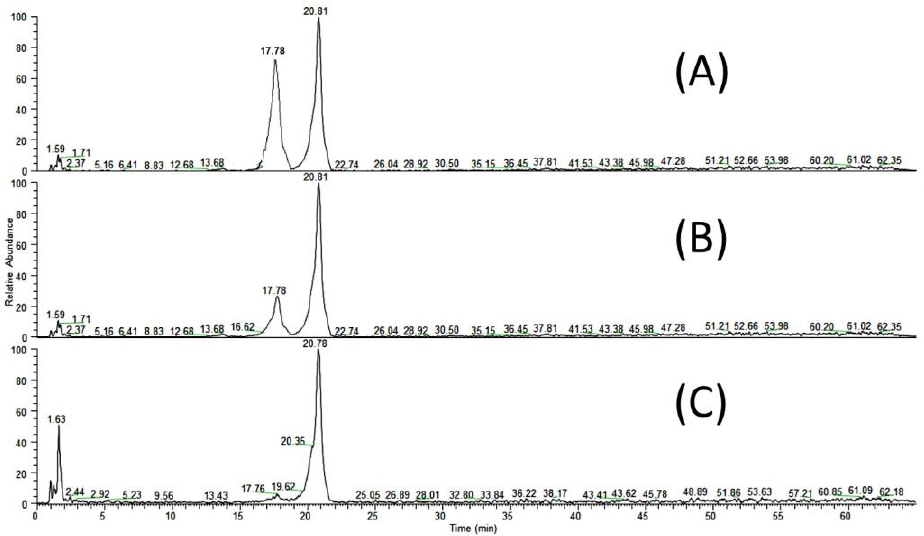
Figure 3. Reconstructed ion chromatograms (RIC) of ions at m/z 441, corresponding to [M + H] + DFP in samples: ( A ) NC white-1 , ( B ) NC yellow , and ( C ) NC white-2 .